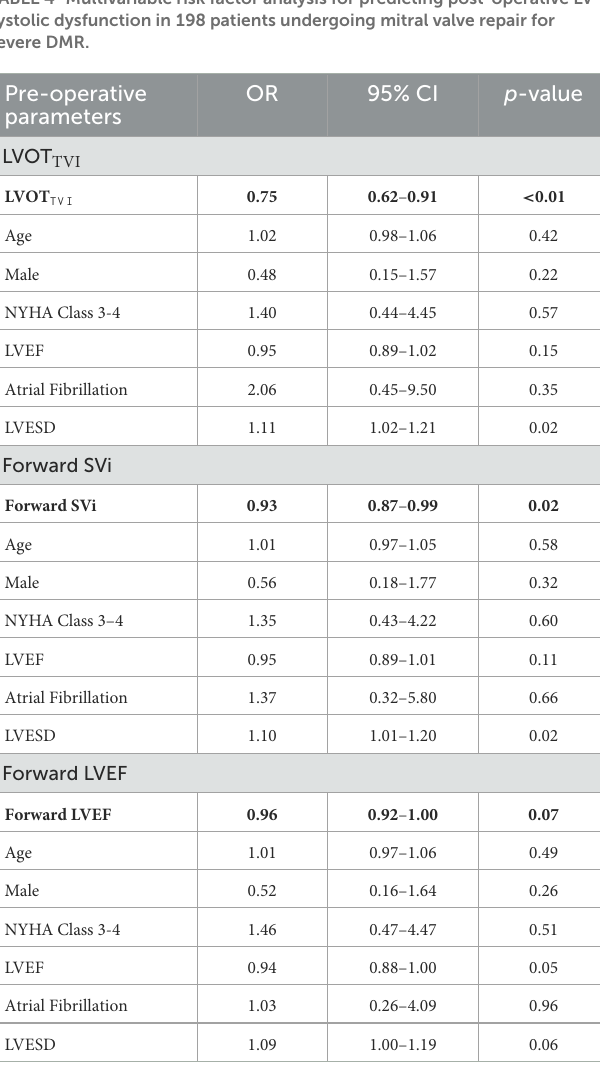
Optimal thresholds for LVOT and forward LVEF ROC curves identified thresholds of 15cm for LVOT TVI (Se =